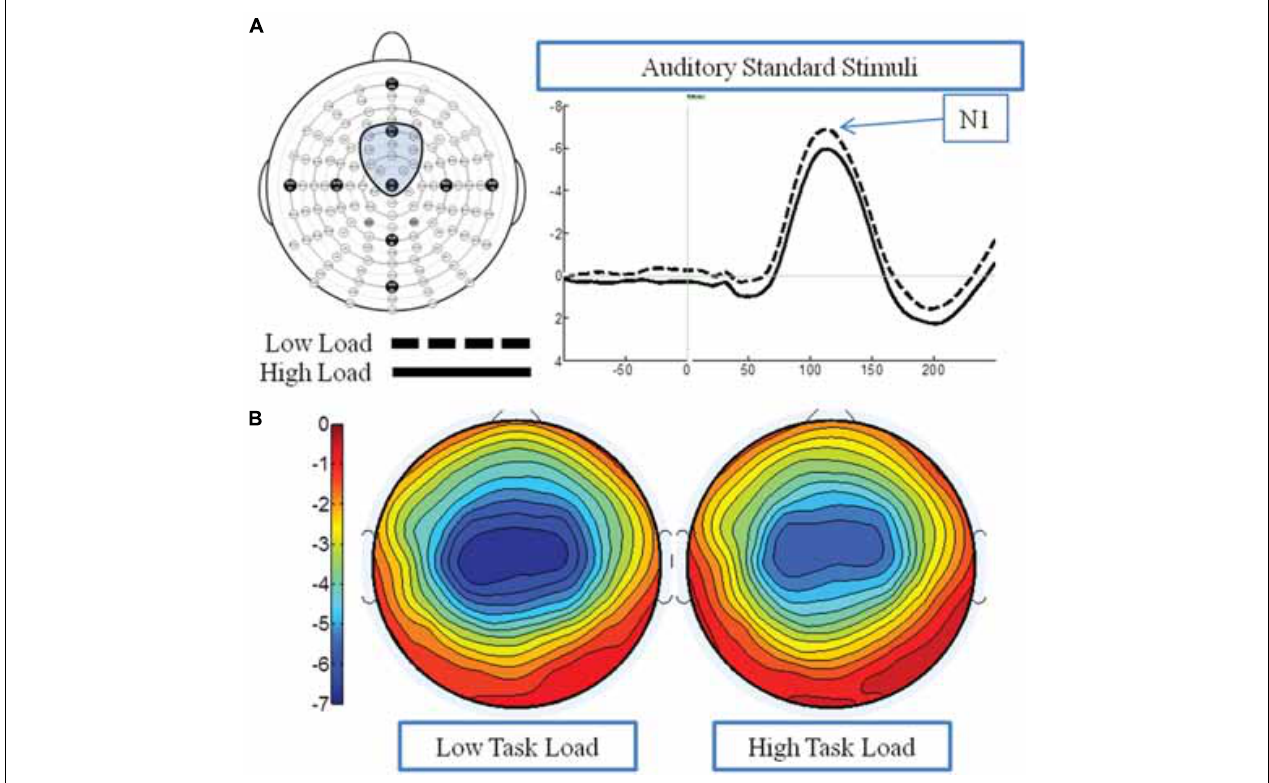
FIGURE 5 | Event-related potential data in response to standard auditory stimuli under the low and high load conditions. (A) Illustrates the grand average waveform (arrow points to the N1 component); and (B) shows the surface potential maps for the N1